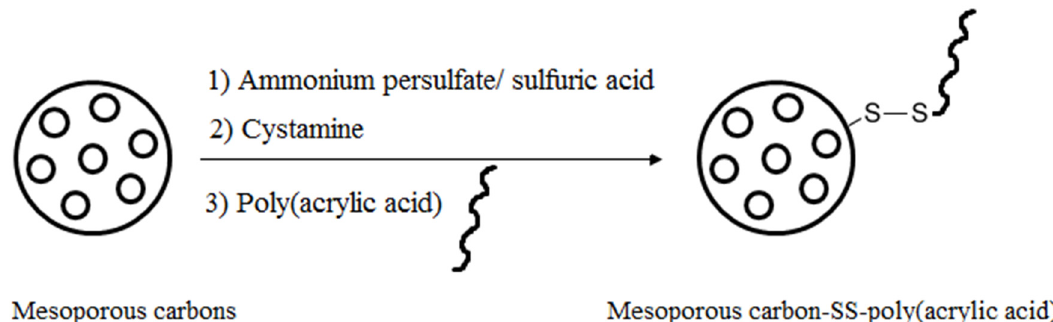
Figure 8. Surface modification of mesoporous carbons with poly(acrylic acid).